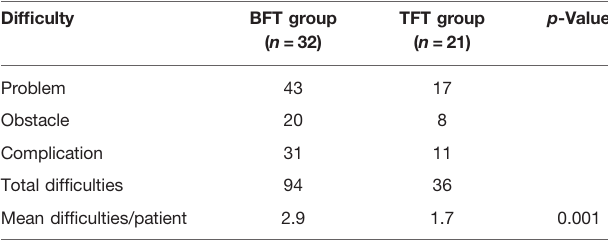
TABLE 4 | Dif fi culties during treatment in the two groups.